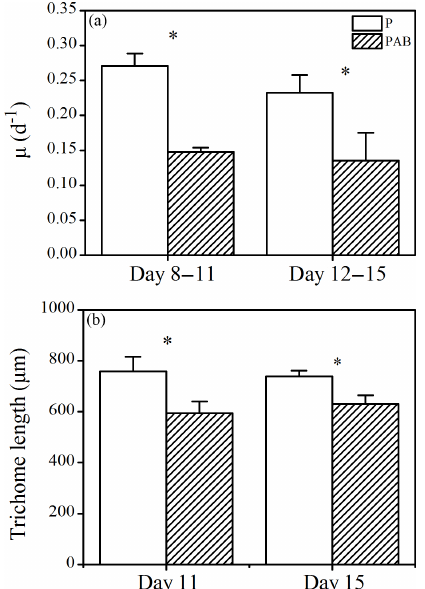
Figure 4. (a) Specific growth rate (measured during 8th–11th and 12th–15th days) of Trichodesmium IMS101 grown under solar PAR (P) and PAR + UVA + UVB (PAB). Corresponding total so- lar doses from day 8 to day 11 and from day 12 to day 15 were 17.03 and 18.51MJ, respectively. (b) Trichome length (measured on the 11th and 15th day) of Trichodesmium IMS101 grown under solar PAR (P) and PAR + UVA + UVB (PAB). The asterisks indi- cate significant differences between radiation treatments. Values are the mean ± SD for triplicate